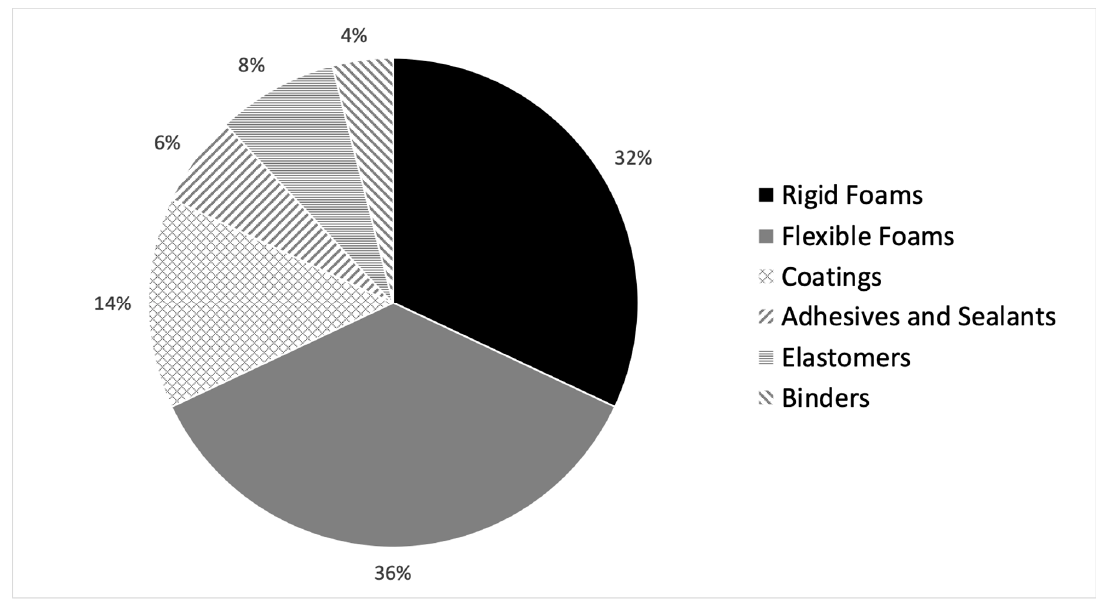
ff erent types of polyurethane products. Figure 1. Market share of different types of polyurethane products. Figure 1. Market share of di